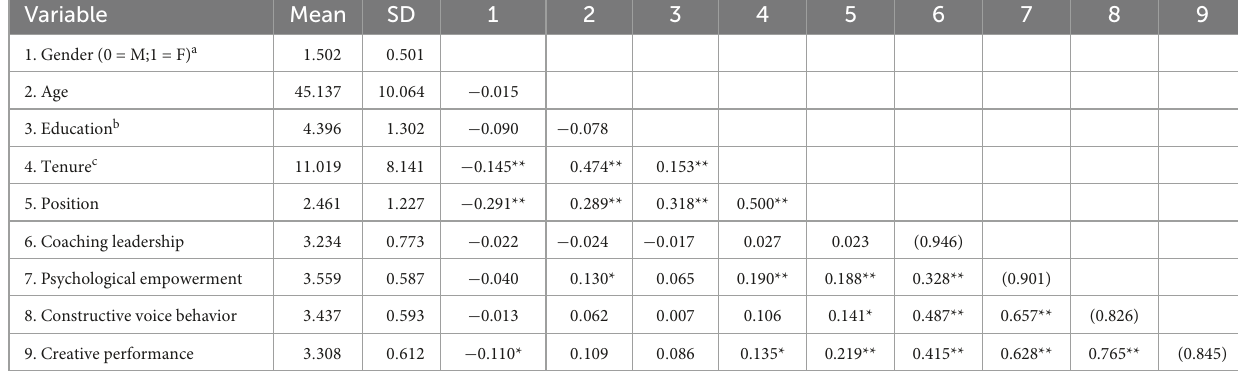
TABLE 1 Descriptive statistics and correlations.